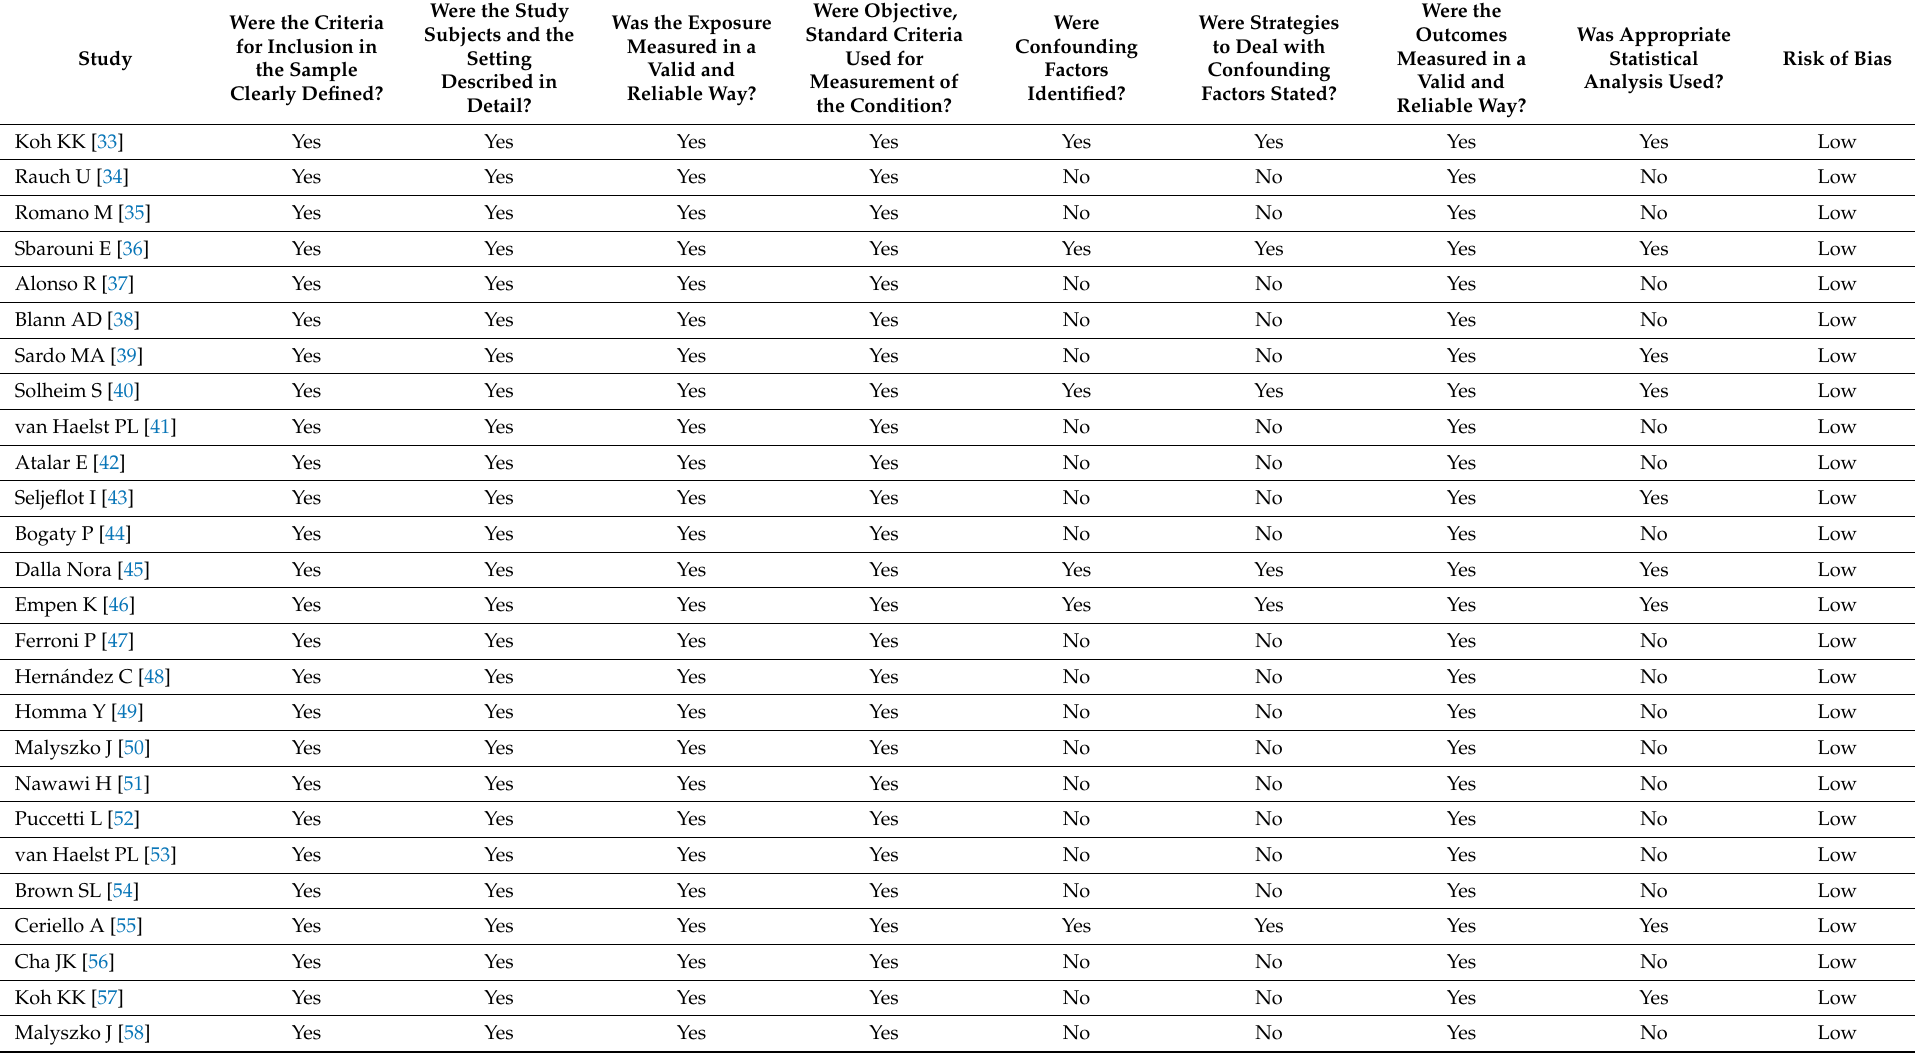
Table 2. The Joanna Briggs Institute critical appraisal